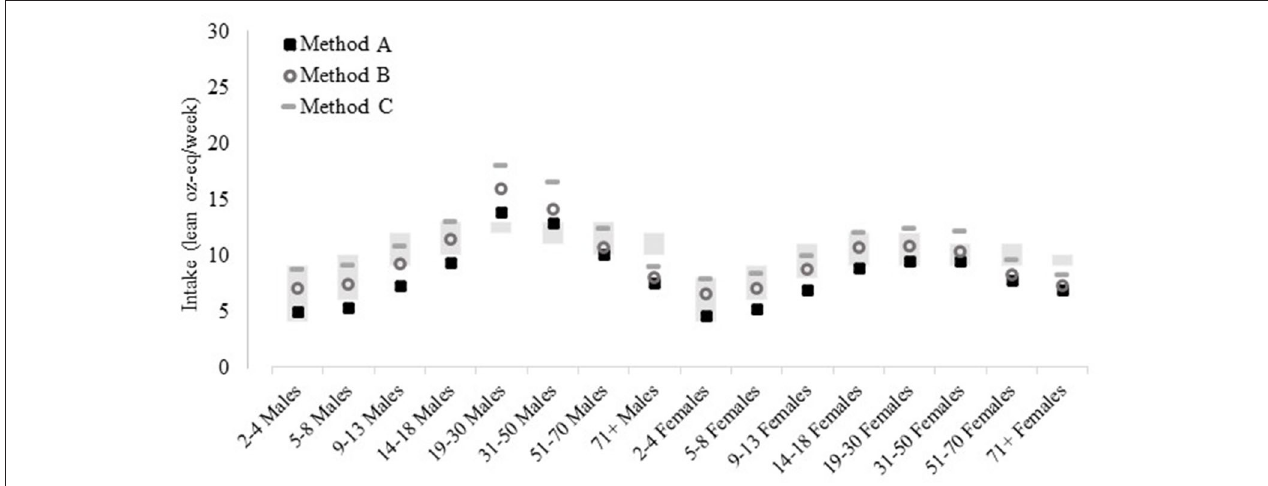
FIGURE 7 | Poultry intakes estimated by various poultry food group methods compared to allotment ranges in the US 2020–25 Dietary Guidelines for Americans recommended eating patterns, by age and sex, estimated via different methods. Method A: Unprocessed poultry, includes chicken, turkey, Cornish hens, duck, goose, quail, and pheasant (game birds); excludes organ meat and cured meat; additionally excludes chicken patties, nuggets, and tenders. Method B: Unprocessed poultry, includes chicken, turkey, Cornish hens, duck, goose, quail, and pheasant (game birds); excludes organ meat and cured meat and includes chicken patties, nuggets, and tenders. Method C (reference): Total poultry, includes unprocessed poultry, processed poultry, and chicken patties, nuggets, and tenders. See Figure 1 for further descriptions of each method. Results are shown as mean estimated via the NCI Method for usual dietary intakes. Data source: US Centers for Disease Control and Prevention/National Center for Health Statistics, NHANES 2015–2018, day 1 and 2 dietary recall data.